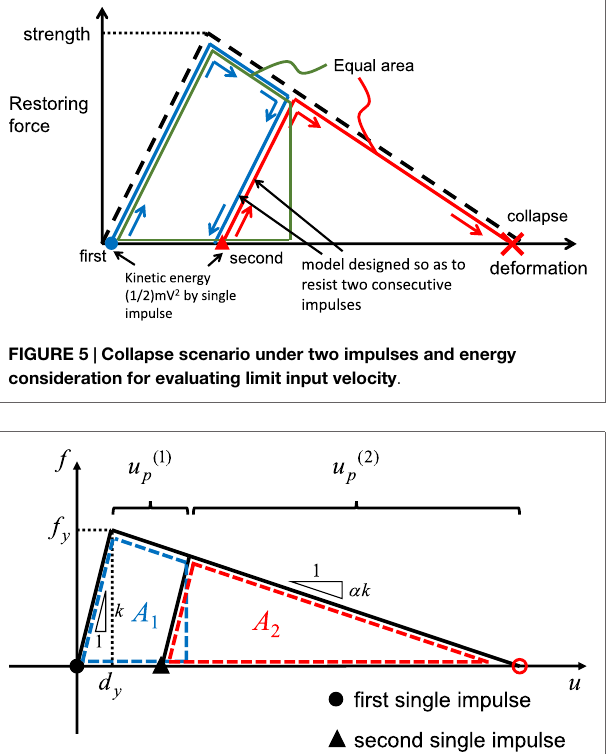
FIGURE 6 | Restoring-force characteristic of model under two impulses